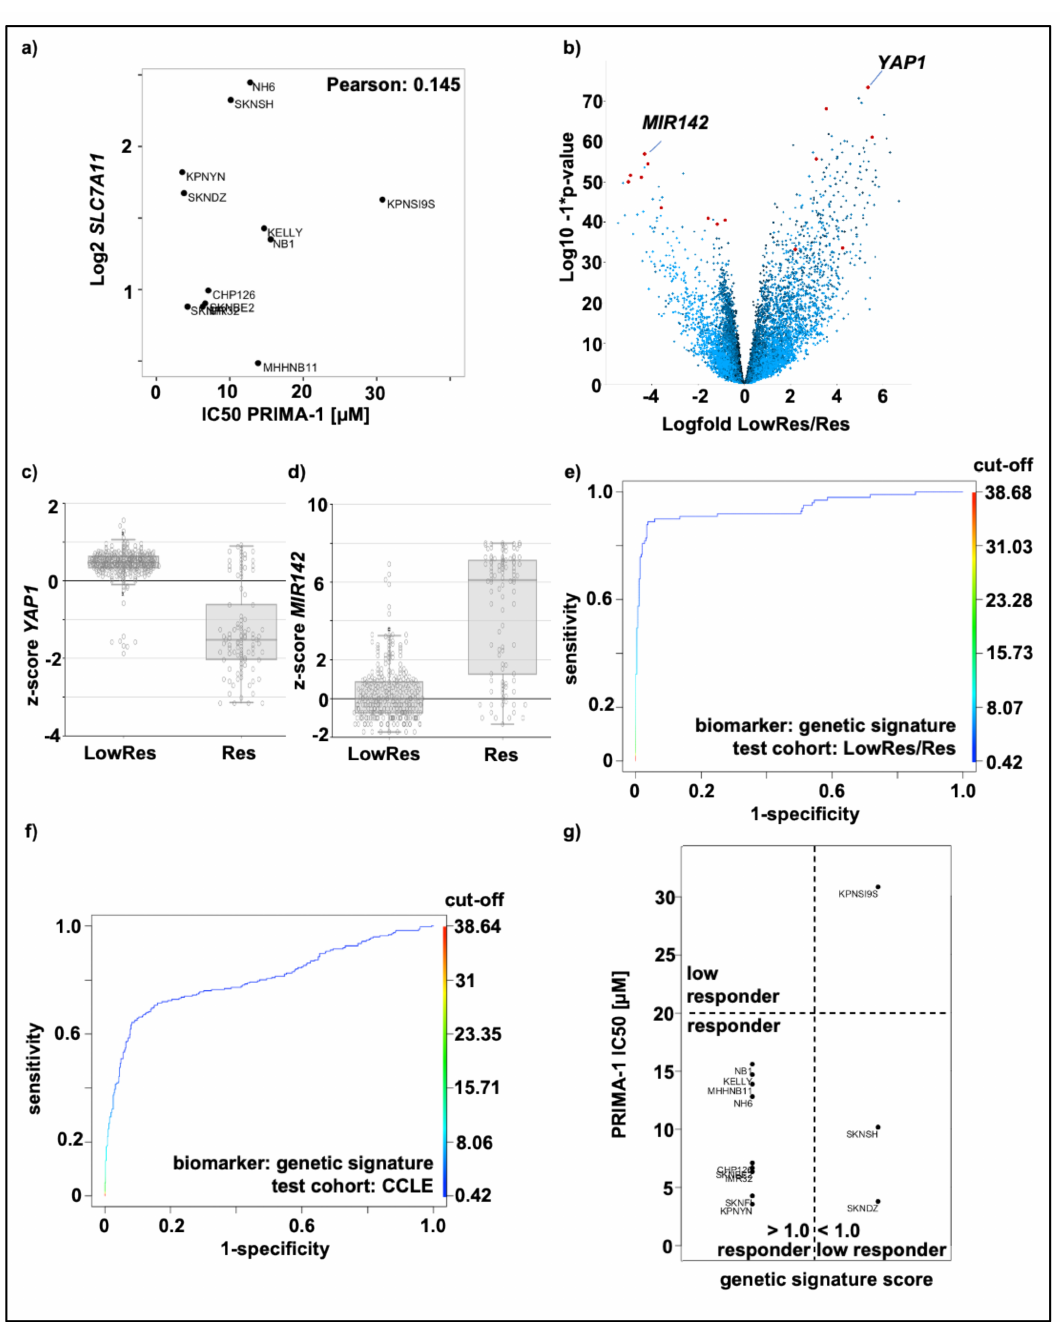
Figure 3. Identification of a biomarker predicting APR-246 responsiveness ( a ): in silico analysis of log2 SLC7A11 and PRIMA-1 sensitivity (IC50 in µ M) with data obtained from Cancer Cell Line Encyclopedia and CTD 2 portal for available neuroblastoma cell lines. The Pearson correlation coefficient (0.145) was calculated using R software ( n = 12); ( b ): volcano plot of differentially expressed genes between less responsive cell lines (PRIMA-1 IC50 app. > 40 µ M, n = 303) and